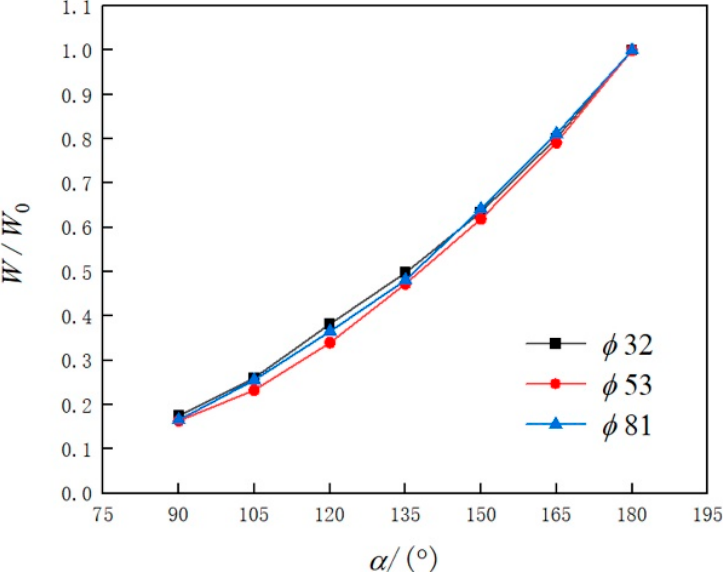
Figure 17. Relative consumed weight W / W 0 changing with the central angle α for helical pipes.